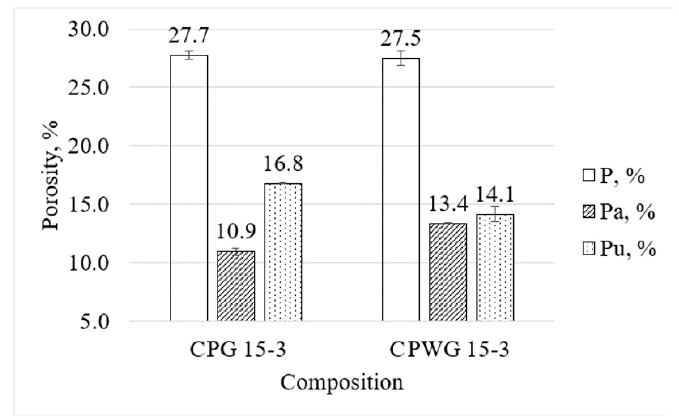
Figure 7. The porosity of alkali activated fine-grained concrete samples. P—total porosity; Pa—open porosity; Pu—closed porosity.